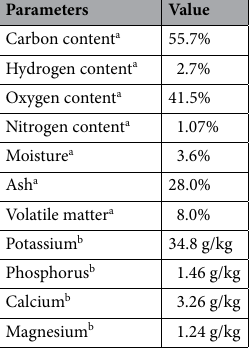
Table 1. Characteristics of EFB Biochar. a Data from Idris et al. 15 . b Data from Idris et al. 14